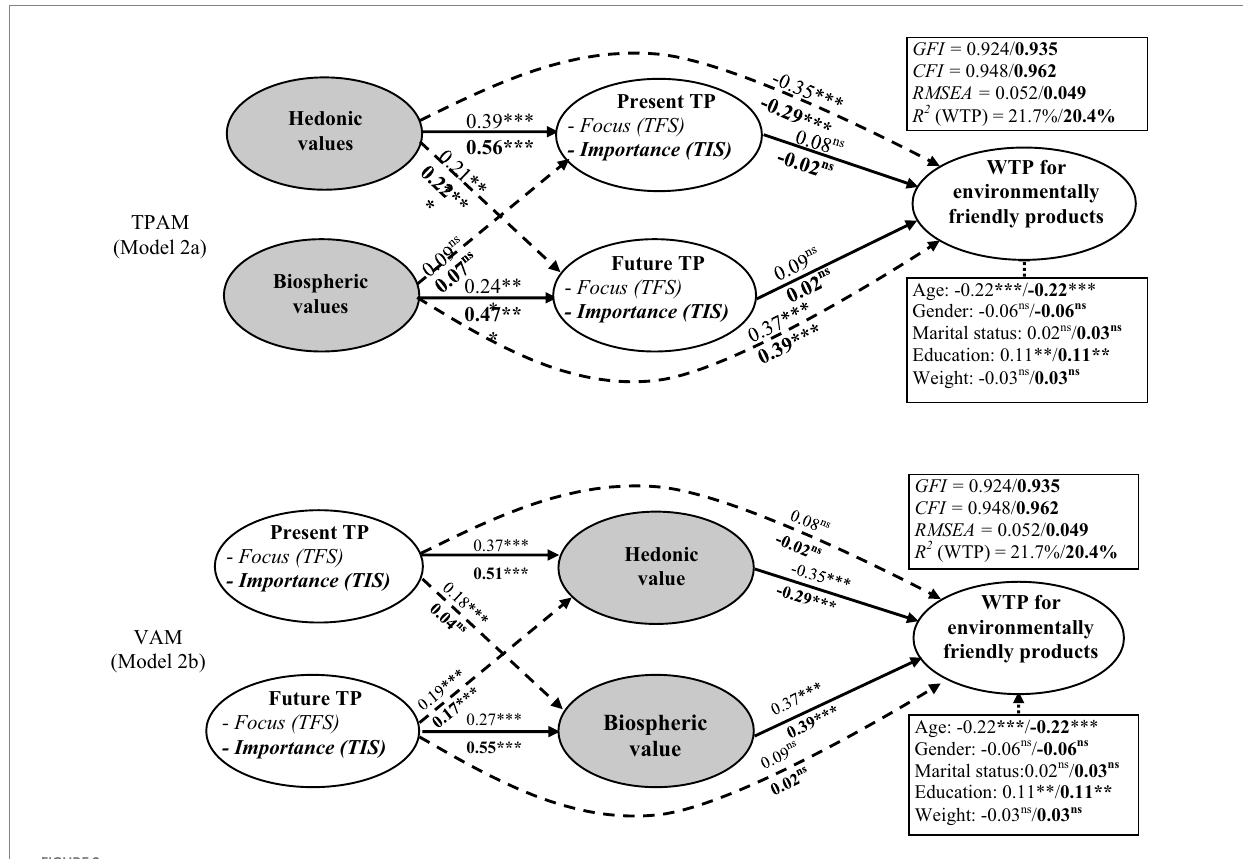
FIGURE 2 Results from alternative models for comparing time focus and time importance. Model 2a: The time perspective activation model (TPAM). Value for the Temporal Importance Scale (TIS) are in bold. ns, non-significant, * p < 0.05, ** p < 0.01, *** p < 0.001. Model 2b: The estimated model of the value activation model (VAM). ns, non-significant, * p < 0.05, ** p < 0.01, *** p <